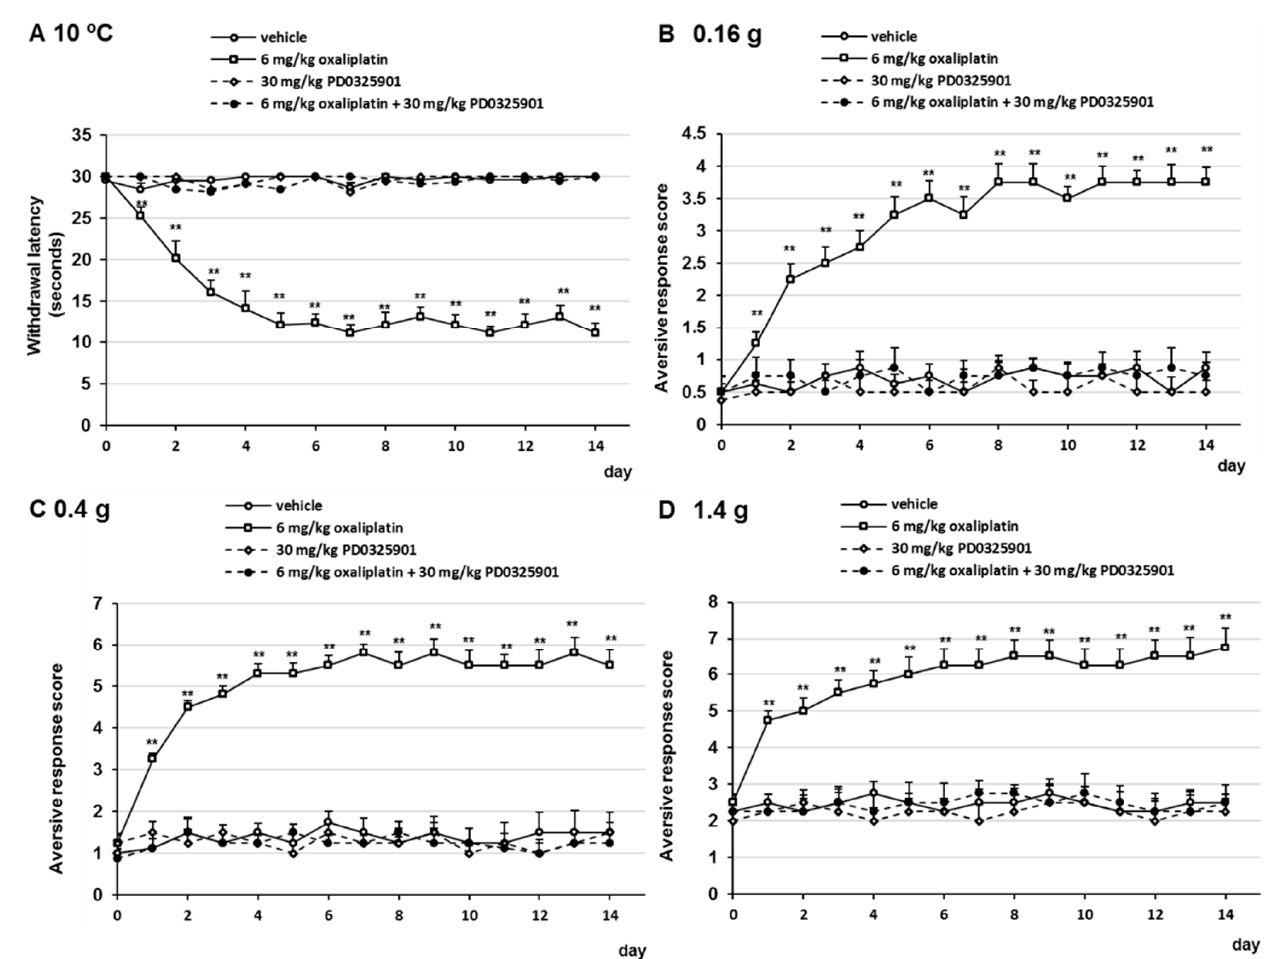
Figure 6. Inhibitory effect of PD0325901 on oxaliplatin-induced cold and mechanical allodynia in mice. Oxaliplatin (6 mg/kg, i.v.) was administered on days 0 and 7, and PD0325901 (30 mg/kg, p.o.) was administered daily from days 0 to 14. ( A ) Withdrawal latencies, presented as means ± standard deviations (S.D.), represent the time taken by mice to withdraw their hind paws following cold stimulation (10 °C) ( n = 7 per group). ** p < 0.01 vs. vehicles (Shapiro–Wilk test and Kruskal–Wallis test followed by the Scheffe test). ( B – D ) The number of paw lifts elicited by five mechanical stimulations using von Frey filaments corresponding to ( B ) innocuous (0.16 g), ( C ) intermediate (0.4 g), and ( D ) noxious (1.4 g) bending forces. The aversive response score was calculated based on two paw lifts ( n = 7 per group). ** p < 0.01 vs. vehicles (Shapiro-Wilk test and one-way analysis of variance (ANOVA) with Tukey